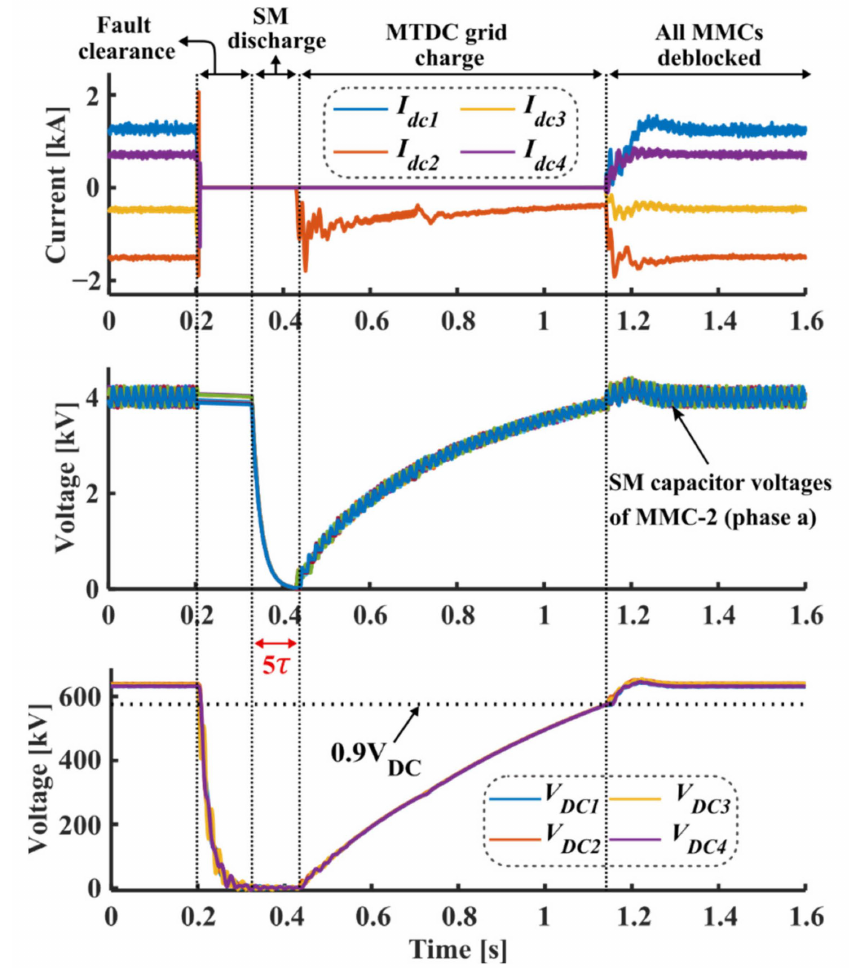
Figure 14. DC currents, voltages, and MMC-2 SM voltages with fault at location